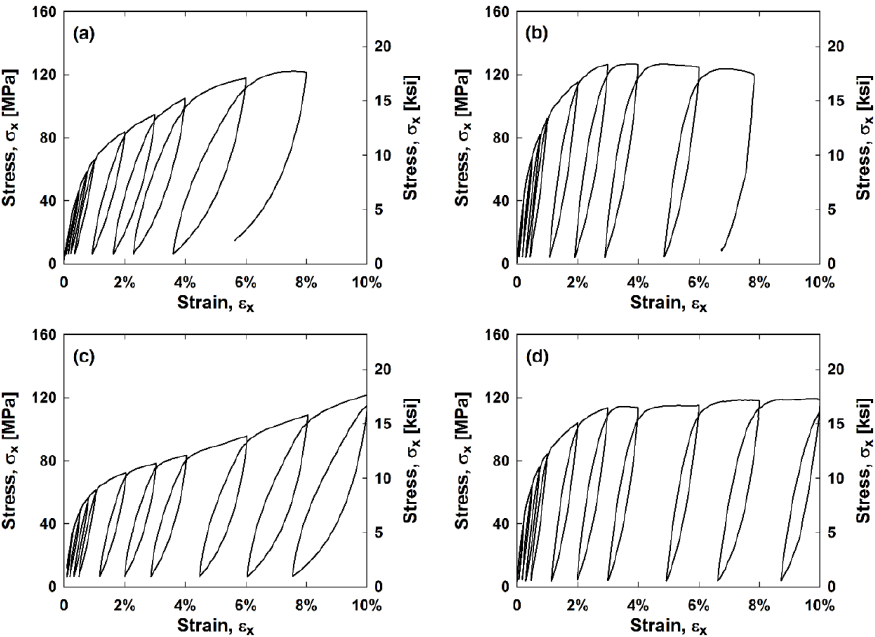
Figure 2. Average ( a ) E-glass; ( b ) E-glass hybrid; ( c ) S-glass; and ( d ) S-glass hybrid composite stress–strain curves.